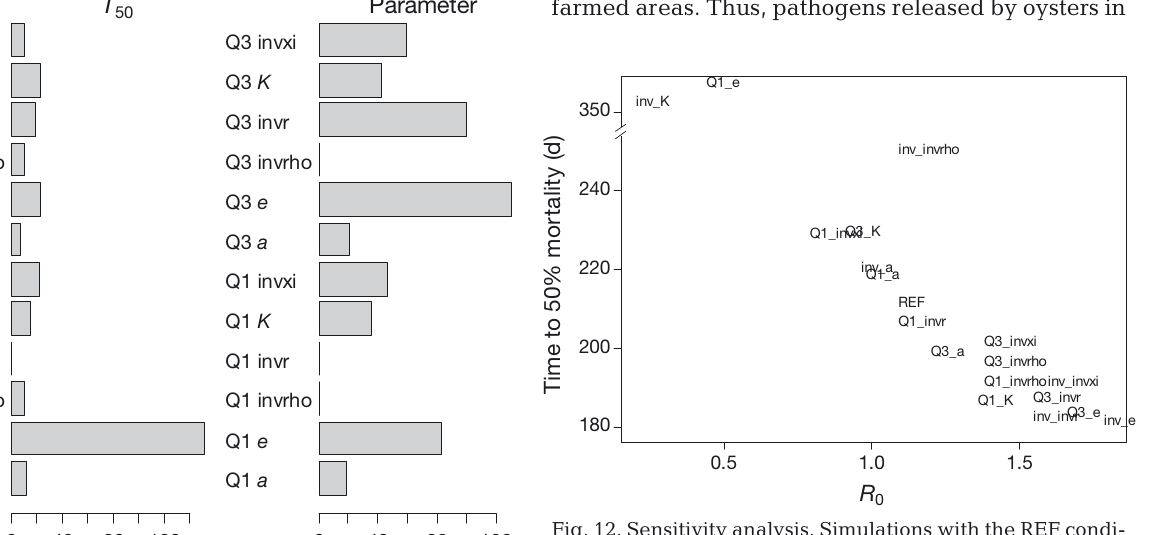
Fig. 12. Sensitivity analysis. Simulations with the REF condi- tions were run with different sets of epidemiological para - meters. Each dot represents a simulation, and the time to ob- tain 50% mortality ( T 50 ) was plotted against the contagion parameter ( R 0 ). The highest T 50 values correspond to the du- ration of the simulation (365 d) and are underestimated. Note that the y -axis has a break mark and the scale is not continuous. Q_parametername corresponds to the simula- tion with the corresponding Q value of the parameter’s ob- served experimental distribution; inv_parametername cor- responds to a simulation where the value of a parameter at low temperature replaced the value at high temperature. See Fig. 10 for